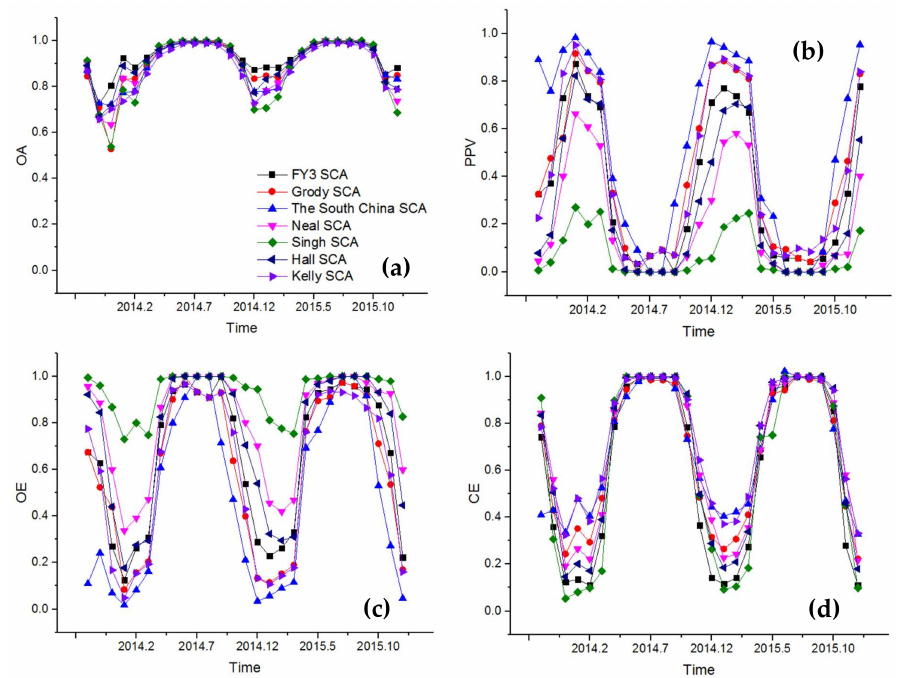
Figure 3. Monthly OA ( a ), PPV ( b ), OE ( c ) and CE ( d ) of the seven PMW SCA maps based on in situ SD